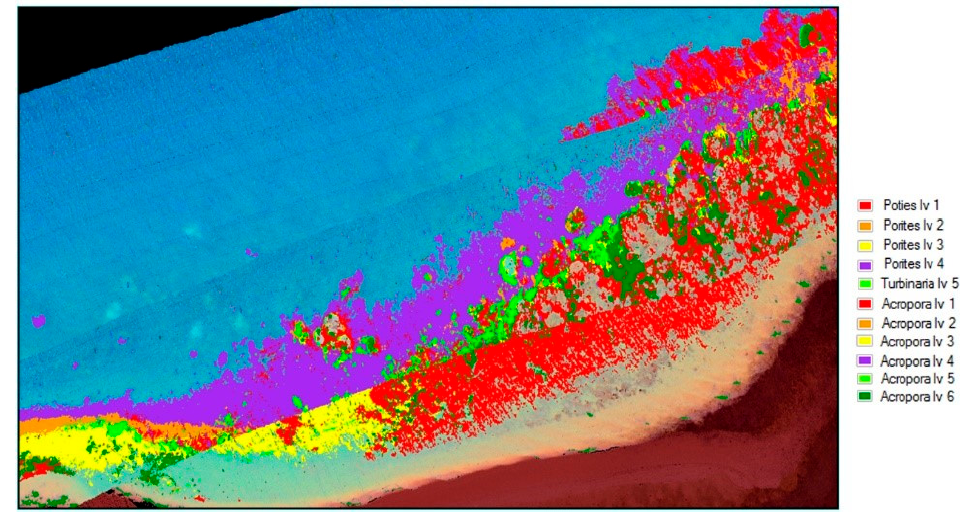
Figure 21. Support vector machine (SVM) material classification for Pandora Reef. Table 3 Results of the accuracy assessment with labelled data material classification has been completed. Table 3. Material classification accuracy assessment for Figure 21 (EA = excessive area).